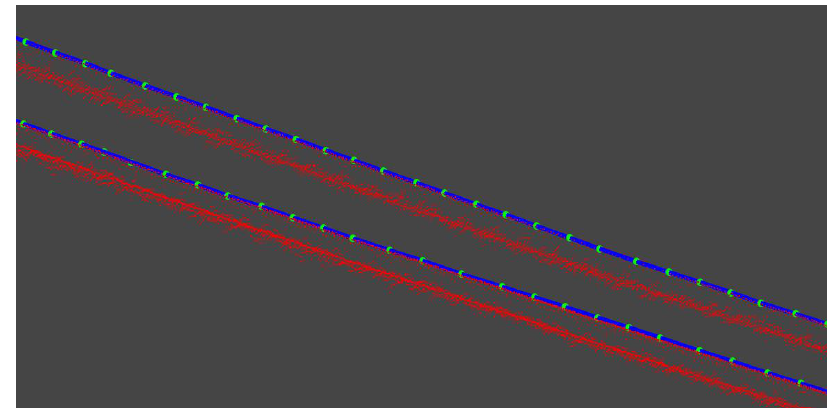
Figure 8. Rail track point cloud classification: ( a ) Scan angle classified cloud points, rail track points ( red ) and remaining points ( white ); ( b ) Rail track points detail.